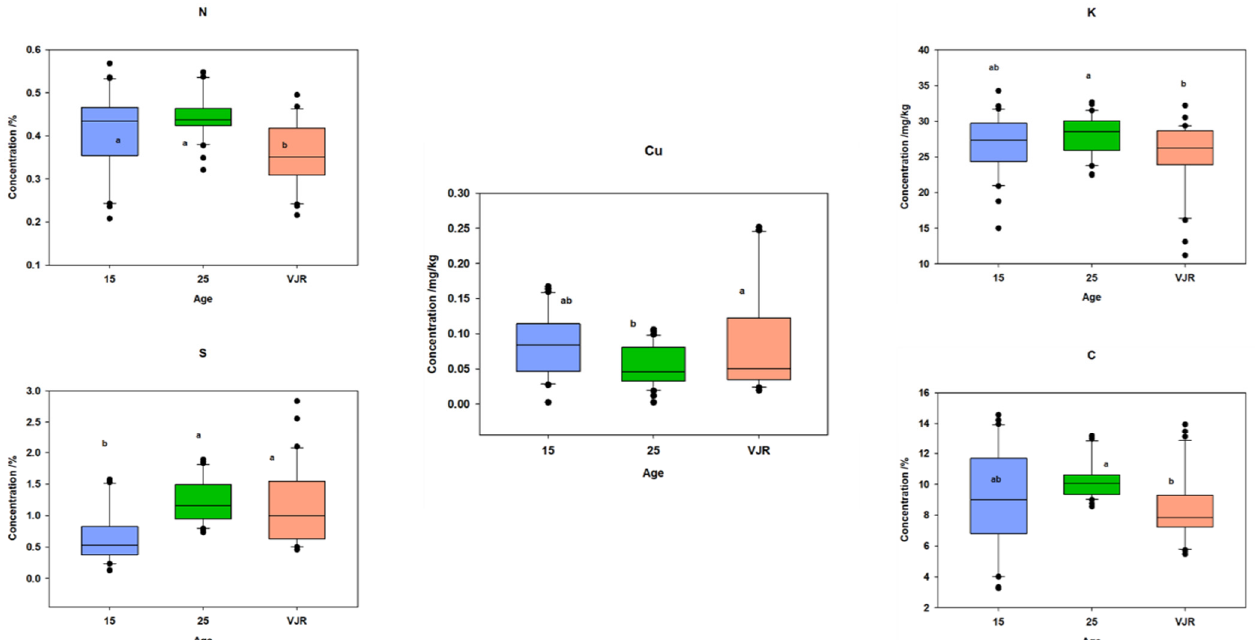
Figure 6. Elemental concentration in sediments (the mean was taken for the same age compartments) in boxplot representation with the median, interquartile range, and outliers (black dots). Small letters (a, b, c) show different significance groups where the significance level was set as p < 0.05.